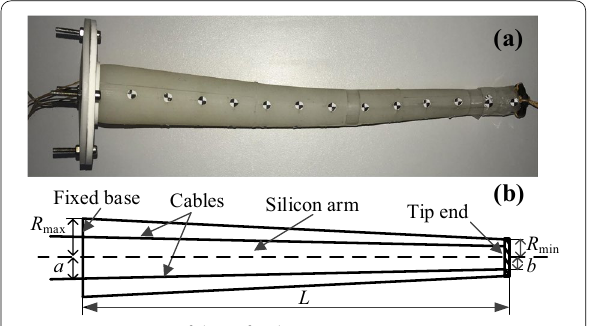
Figure 1 Structure of the soft robot arm